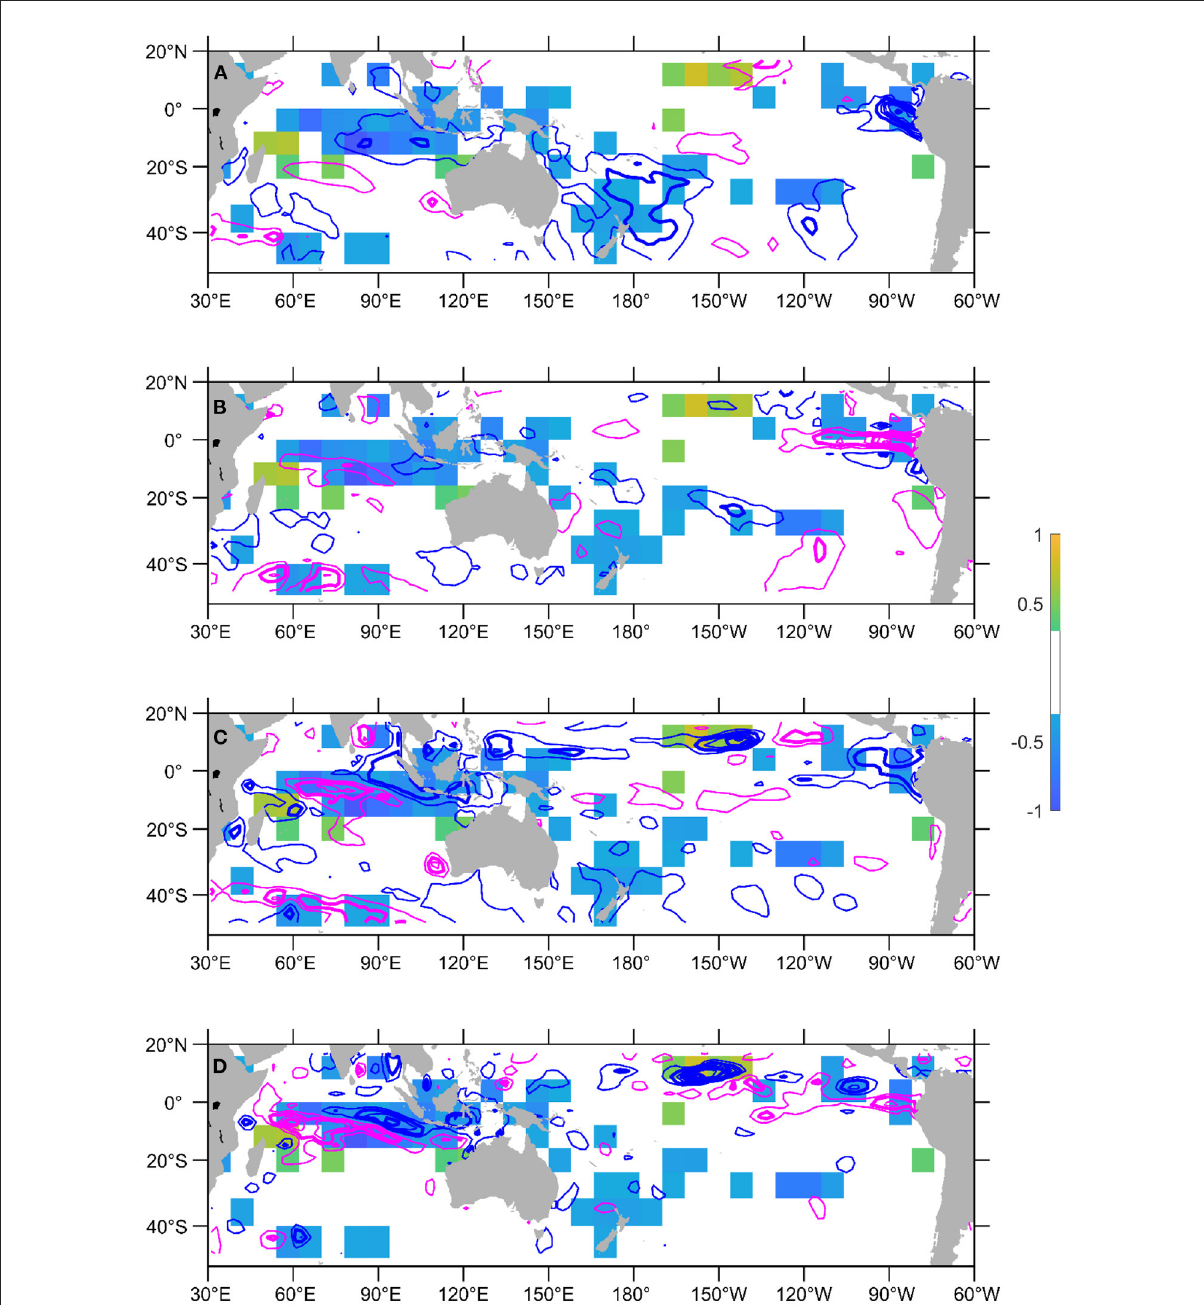
FIGURE5 Activation map of using May-June-July SST and heat content anomalies to forecast the September 1994 EIOD peak (only showing absolute values > 0.3). The activation map is overlaid with (A) SST anomalies in June 1994, (B) SST anomaly differences between July and May 1994, (C) heat content anomalies in June 1994, and (D) heat content anomaly differences between July and May 1994. Negative anomalies are denoted with blue contours and positive anomalies with magenta. Anomalies are plotted every 0.5 ◦ C, and the integer values are in bold contour. Zero contour lines are not